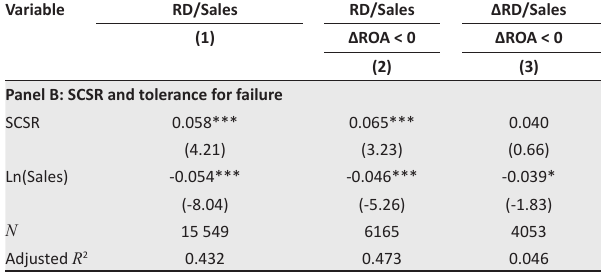
TABLE 5B: Further analyses.